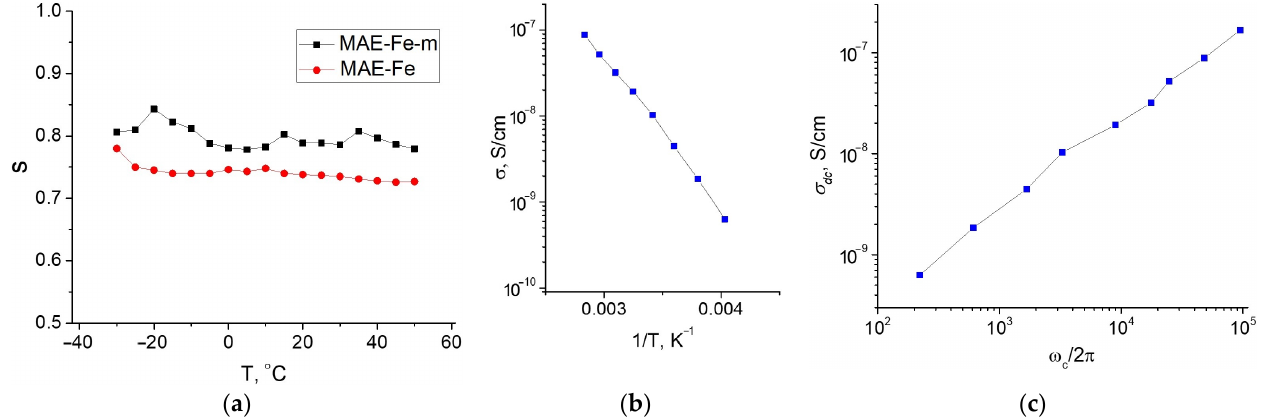
Figure 4. ( a ) Temperature dependence of the parameter s for MAE–Fe and MAE–Fe–m samples; ( b ) Arrhenius-type dependence of the conductivity of MAE–Fe–m; ( c ) log-log plot of σ dc on the critical frequency ω c for